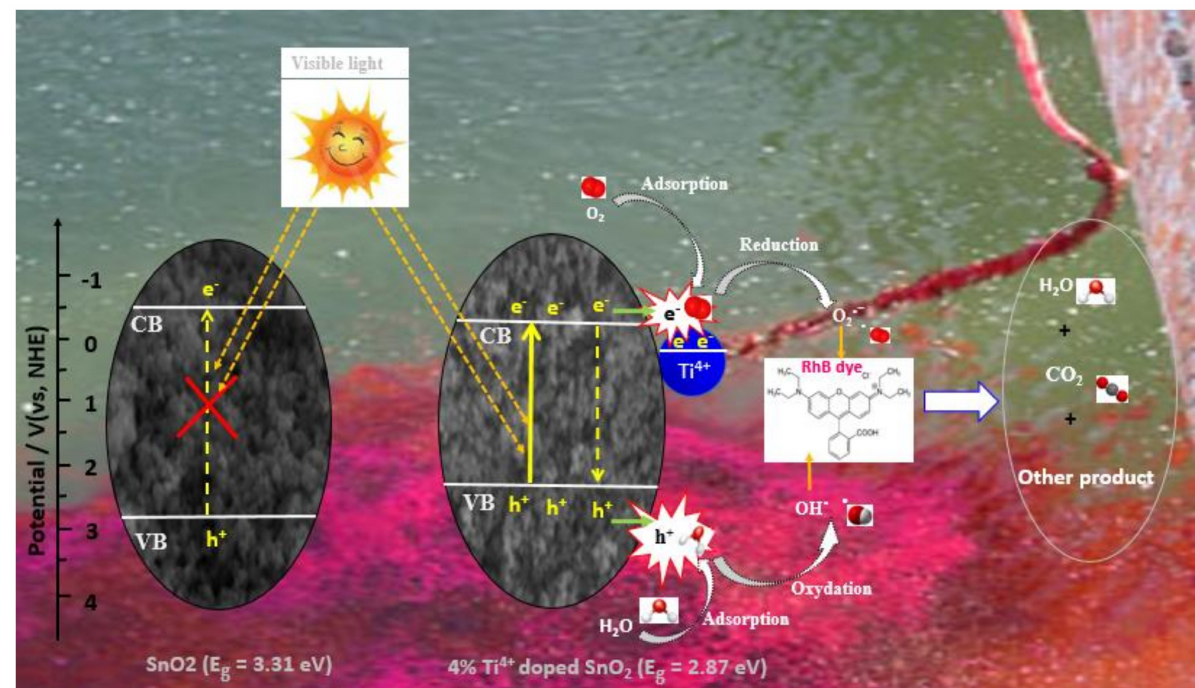
Figure 11. Diagram of the proposed photocatalytic mechanism of Ti–SnO 2 based photocatalysts under Visible light exposure (VB: valence band and CB: conduction